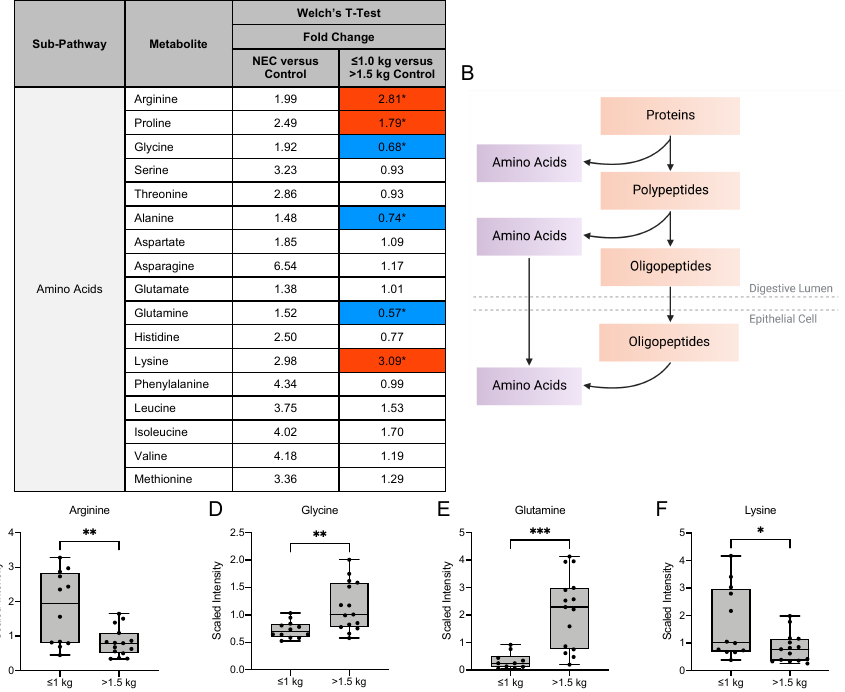
Figure 5. Amino acid composition of breast milk varies by birth weight in control infants. ( A ) Fold change concentration of amino acids in maternal milk. Red cells indicate mean values that are significantly higher and blue cells indicate mean values that are significantly lower for the designated comparison. ( B ) Intake of amino acids in breast milk is followed by catabolism by the intestinal mucosa for degradation to dietary amino acid precursors. Figure created with BioRender.com. ( C – F ) Boxplots of concentration levels of arginine, glycine, glutamine and lysine between the birth weight control groups. * p ≤ 0.05, ** p < 0.01, *** p < 0.001 by Welch’s T-Test.